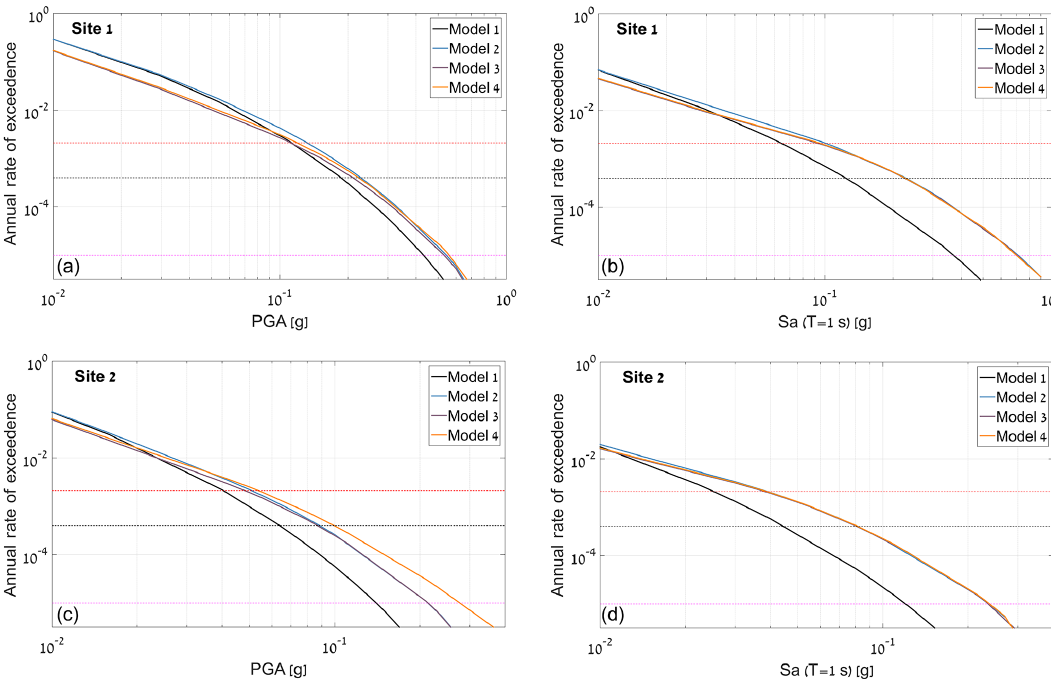
Figure 9. Hazard curves obtained using models 1 through 4 for (a) site 1 at T = 0.01s, (b) site 1 at T = 1.0s, (c) site 2 at T = 0.01s, and (d) site 2 at T =